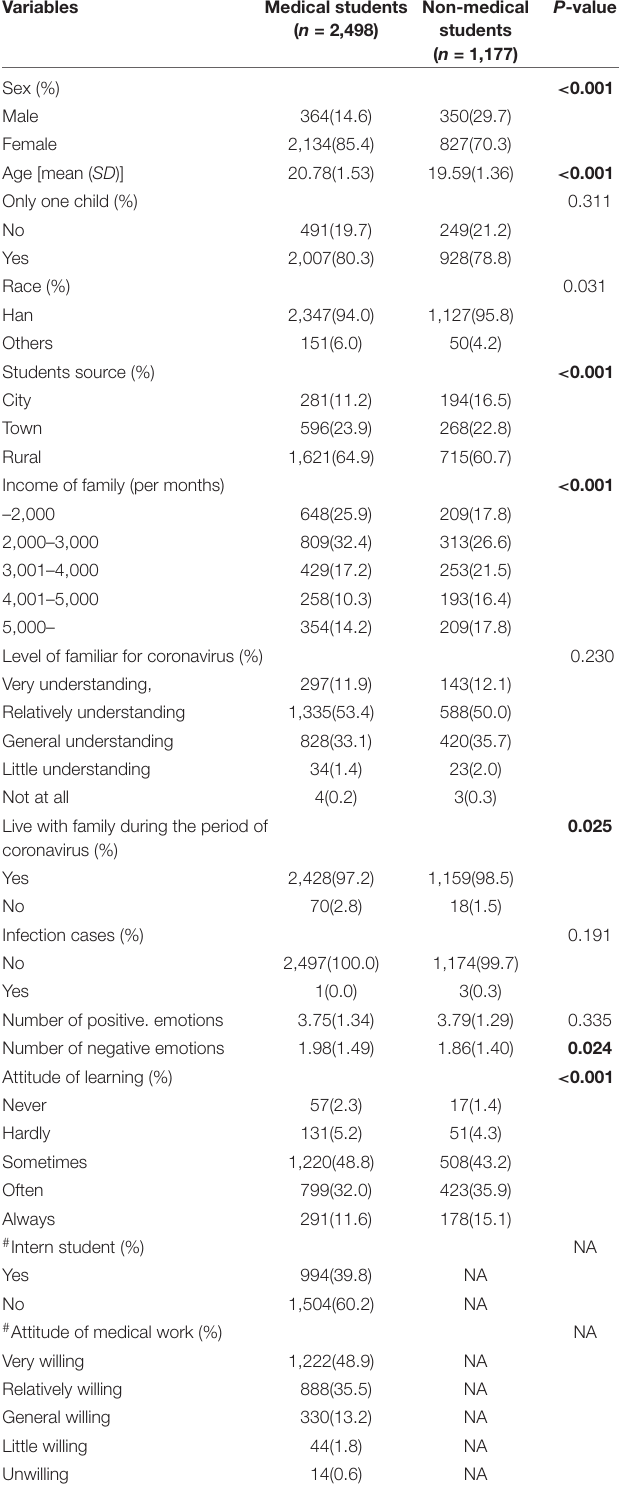
TABLE 1 | The basal characteristics of medical and non-medical students in the design questionnaire.